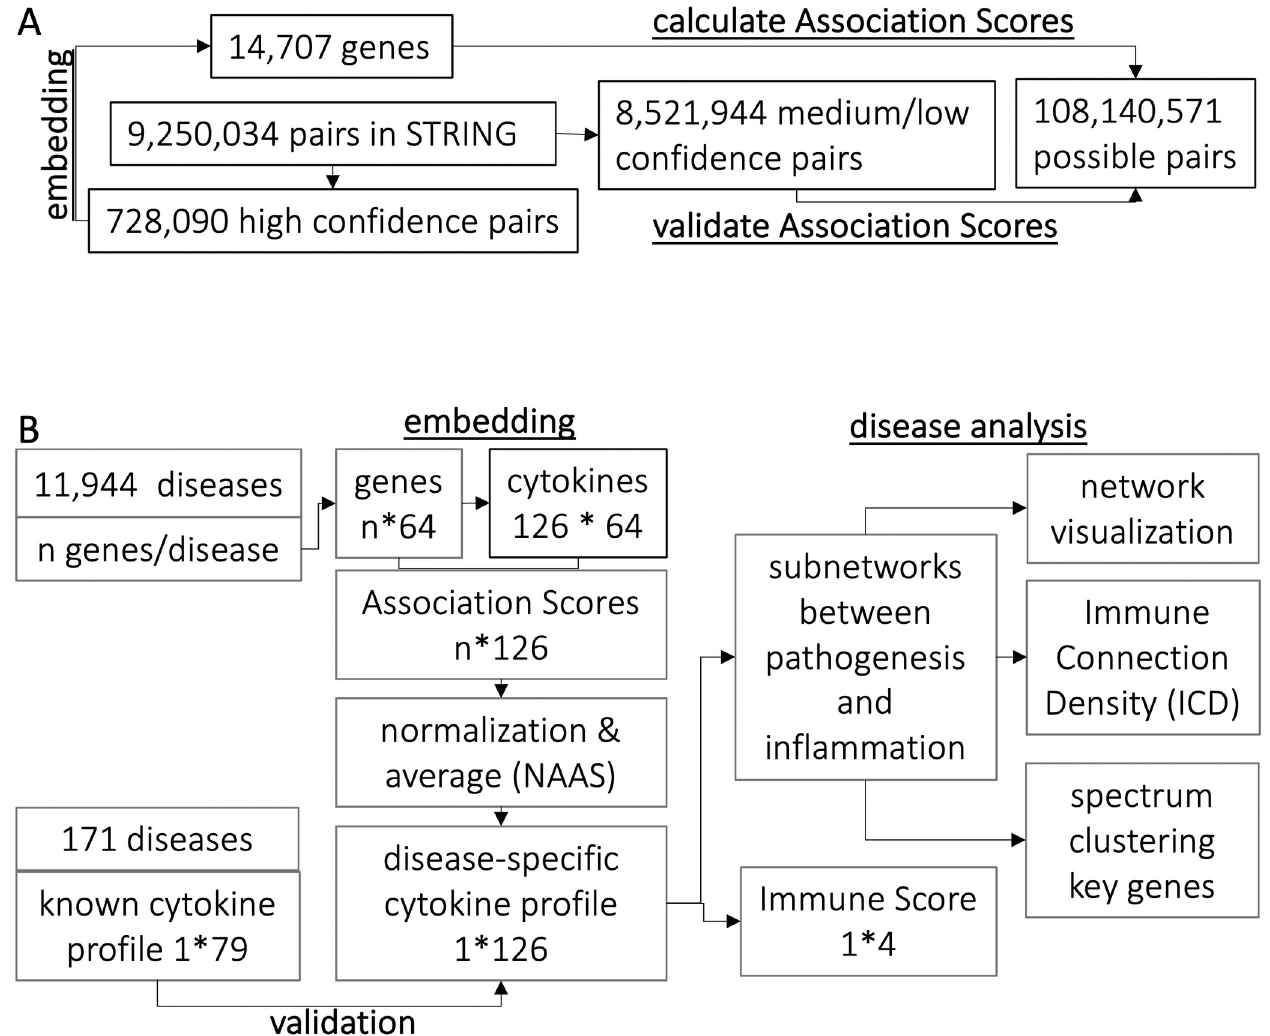
Fig 1. Data flow for (A) predicting Association Scores and (B) analyzing disease-specific cytokine profiles. A. Network features of the high confidence STRING pairs were used to embed 14,707 human genes. The predicted associations between the 14,707 genes were validated using medium and low confidence STRING pairs. B. For each gene associated with a given disease, we calculated Association Scores with each of the 126 cytokines. The Association Scores were averaged and normalized to NAAS that represent the cytokine profile of the given disease. These profiles were further analyzed by (1) calculating Immune Scores and (2) analyzing subnetworks formed between pathogenesis and inflammation by employing network visualization, spectrum partition, and estimation of connection density.